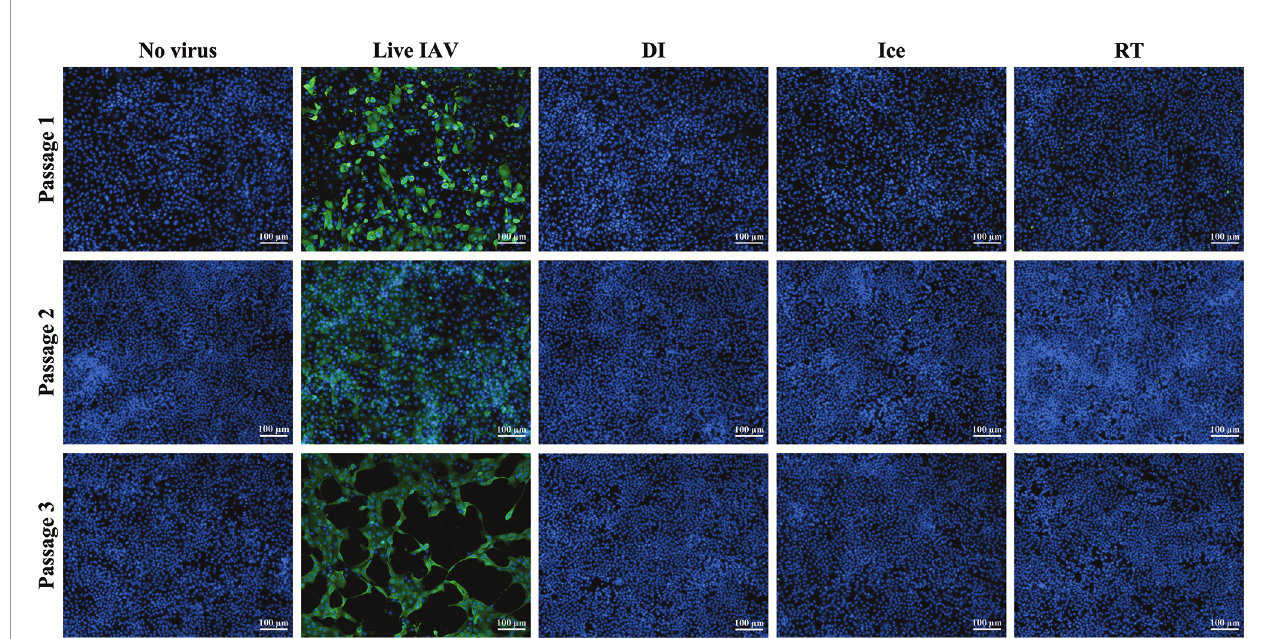
FIGURE 1 | Sterility of g -irradiated IAV. Sterility of g -Flu was assessed by multiple passages in MDCK cells. Live A/PR8 or no virus were used as controls. g -Flu was added to cells at an MOI equivalent of 600. Supernatant from passage 1 was collected 24 hours later and used to infect monolayers of MDCK cells for passage 2, this was then repeated for passage 3. Cell monolayers were stained with DAPI (blue), and IAV-positive cells were visualised with FITC- fl uorescence (green). Samples were tested in triplicate and representative images are presented for each group at each passage.